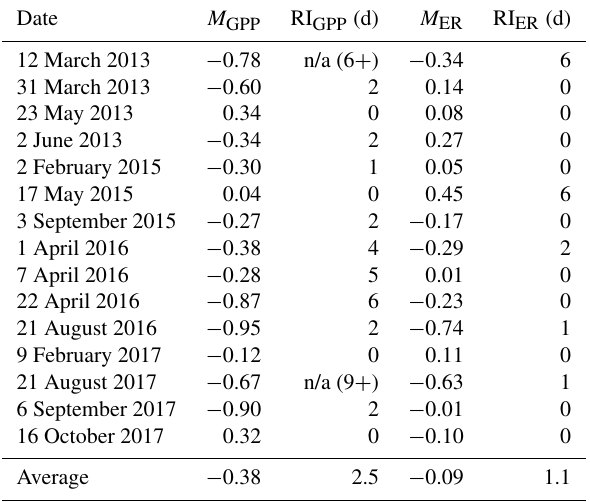
Table 3. Magnitude of departure ( M , unitless) and recovery inter- vals (RIs, days) of gross primary production (GPP) and ecosys- tem respiration (ER) during and after 15 isolated flow events be- tween 8 January 2013 and 14 April 2018. A negative M repre- sents a suppression. A positive M is a stimulation, in which GPP or ER increase relative to the prior mean GPP or ER calculated over 3d. Estimates of M differed between GPP and ER ( t( 26 . 3 ) = 2 . 15, p = 0 . 04), while the RIs for GPP and ER were not significantly dif- ferent ( t( 25 . 8 ) = − 1 . 22, p = 0 . 23). The two instances when GPP did not recover during the isolated flow event analyzed are noted with an “n/a” (not applicable) and the number of days without re- covery ( X + ) that could be counted before the next high flow event